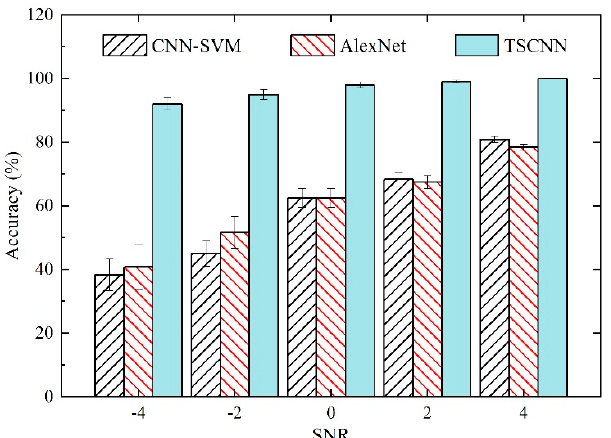
Figure 9. Diagnosis accuracies of the three diagnosis models in different noise environments.